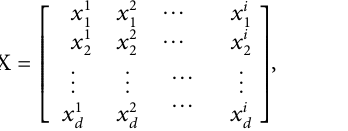
Frontiers in Energy Research |